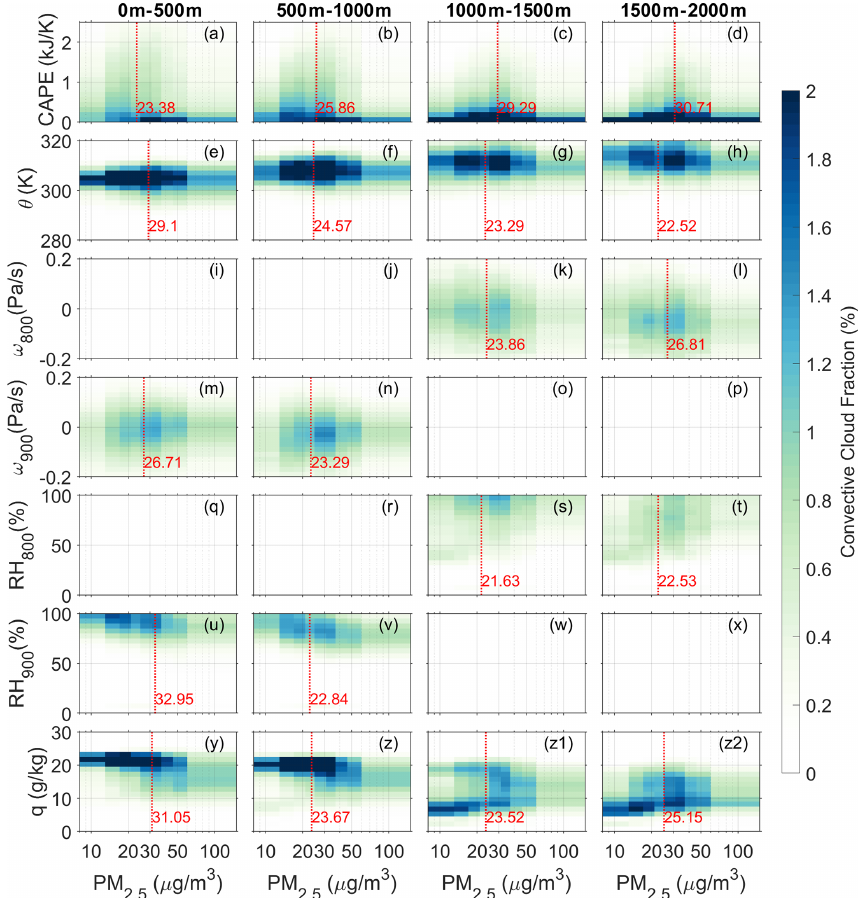
Figure 14. Same as Fig. 13, but for different terrain heights; each column represents a different terrain height range.